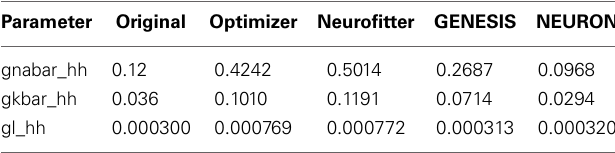
Table 3 | Comparison of the best-fitting parameter values with the original values in Use case